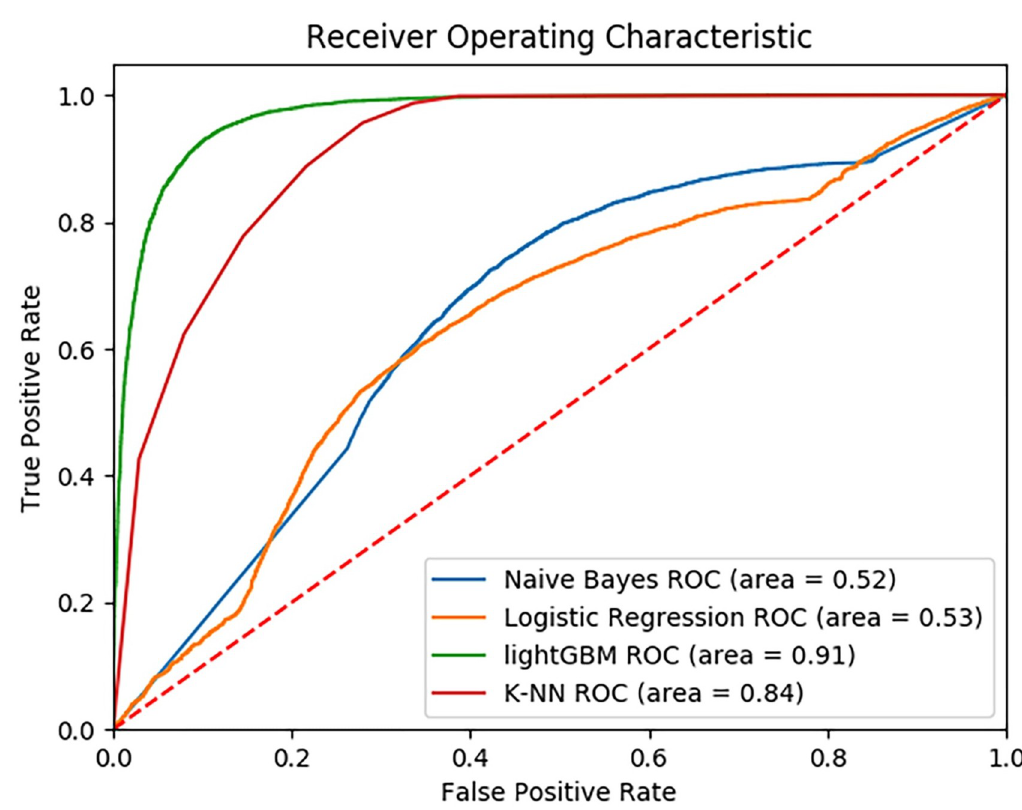
Fig 2. Receiver operating characteristic curve for suicidal thoughts and behavior prediction. We see that the LightGBM model was the highest performing model. Other tree-based models are omitted for clarity, as they performed worse than LightGBM. Higher scores (with curves closer to the upper left corner) are